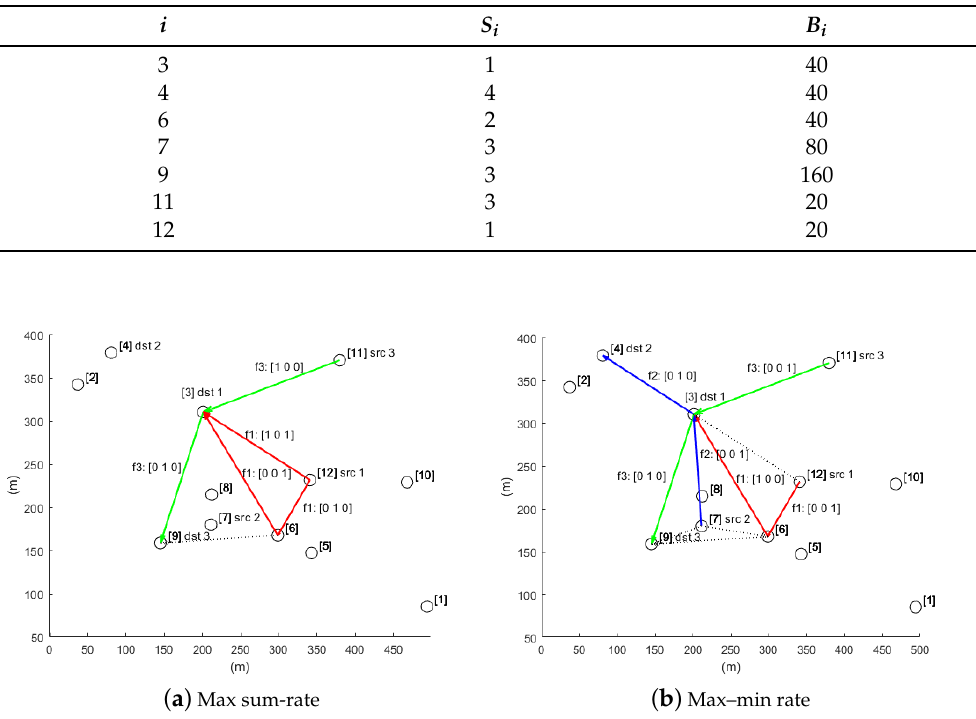
Table 6. Node Configurations for Max–Min Fair Allocation.